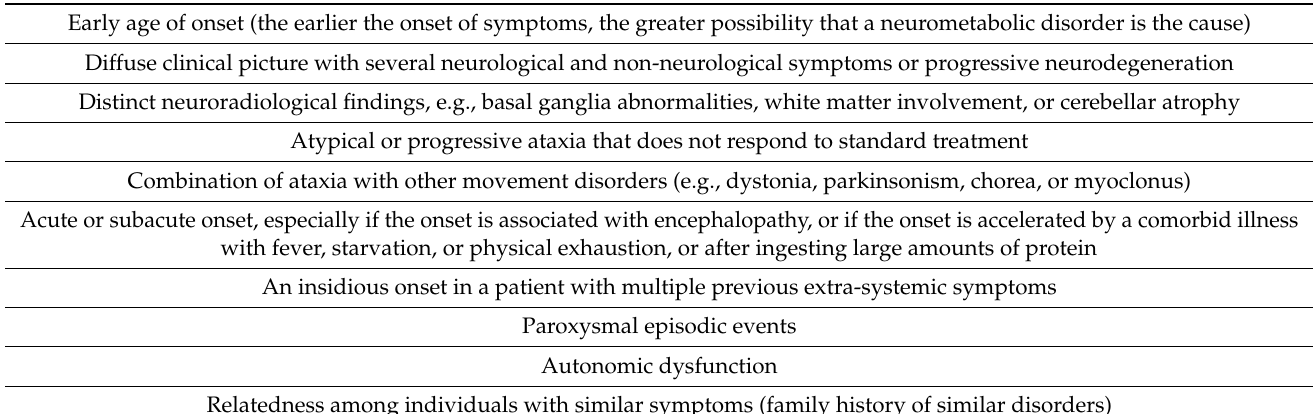
Table 2. Red flags in ataxia pointing to a potential neurometabolic etiology [10,16–18,89]. Early age of onset (the earlier the onset of symptoms, the greater possibility that a neurometabolic disorder is the cause) Diffuse clinical picture with several neurological and non-neurological symptoms or progressive neurodegeneration Distinct neuroradiological findings, e.g., basal ganglia abnormalities, white matter involvement, or cerebellar atrophy Atypical or progressive ataxia that does not respond to standard treatment Combination of ataxia with other movement disorders (e.g., dystonia, parkinsonism, chorea, or myoclonus) Acute or subacute onset, especially if the onset is associated with encephalopathy, or if the onset is accelerated by a comorbid illness with fever, starvation, or physical exhaustion, or after ingesting large amounts of protein An insidious onset in a patient with multiple previous extra-systemic symptoms Paroxysmal episodic events Autonomic